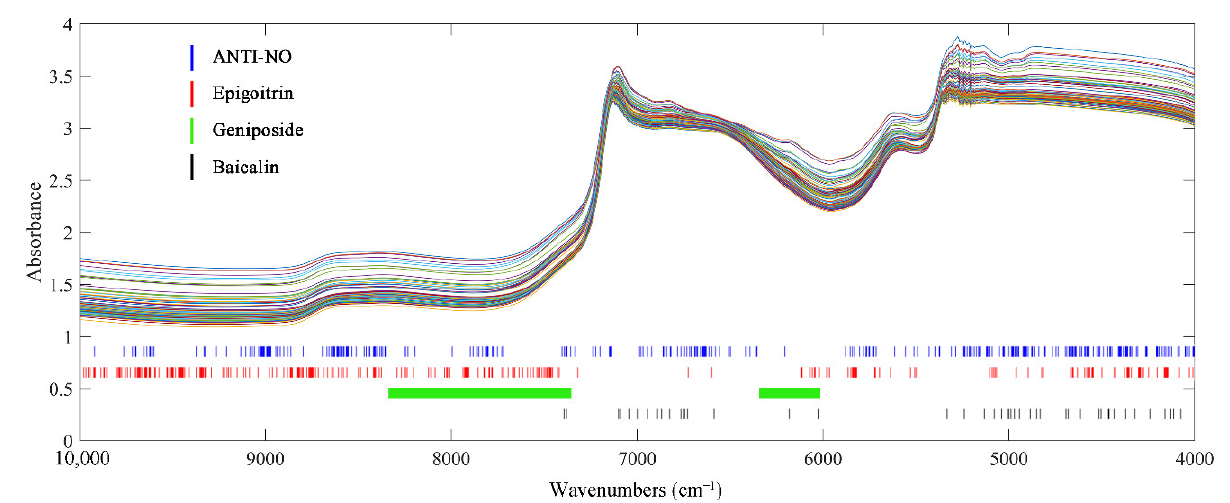
Figure 3. Crucial variables selected of 4 indexes of interest under traditional state.